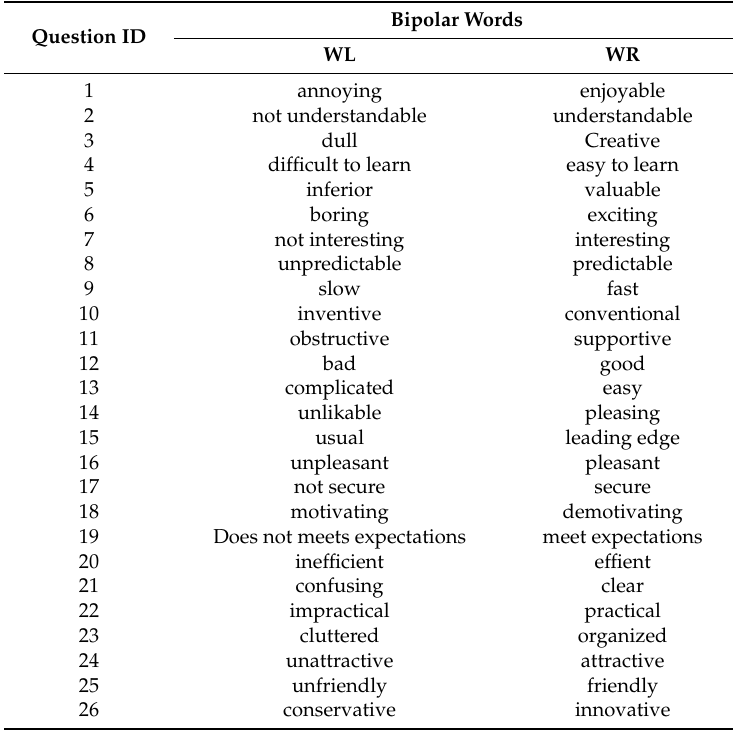
Table A1. The average accuracies of each classifier and fusion